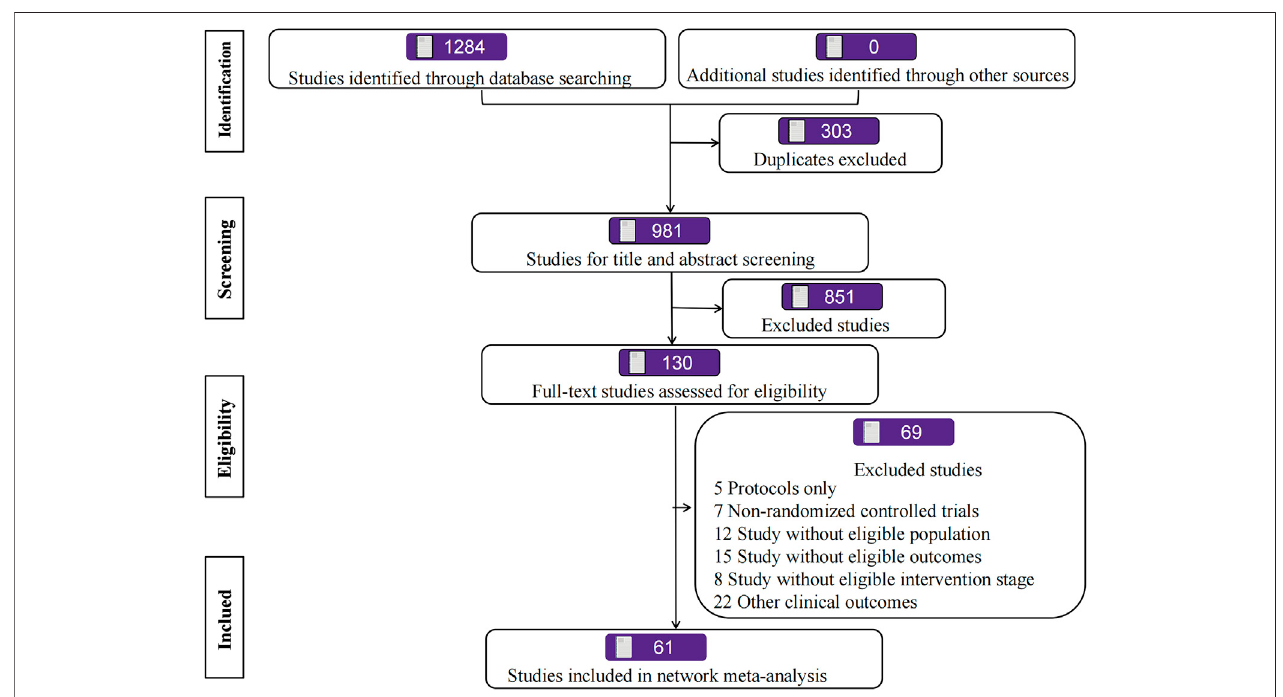
FIGURE 1 | Flow chart of the study